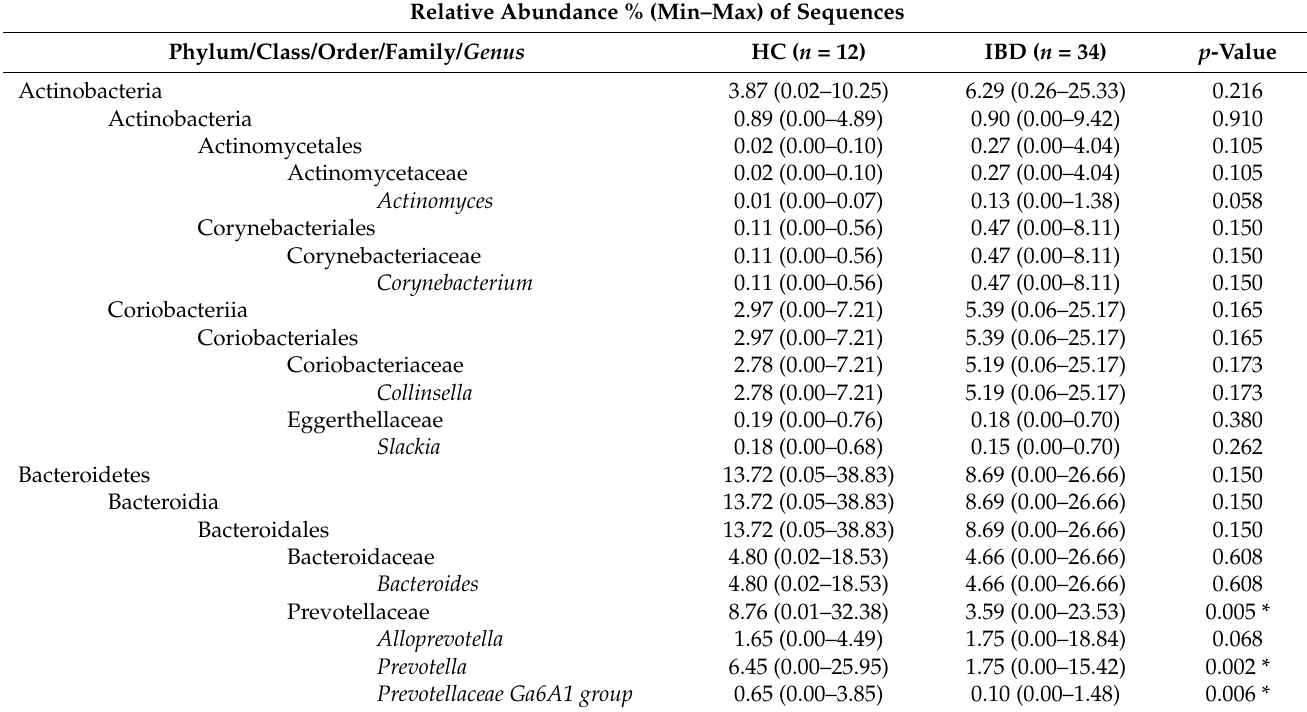
Table 5. Relative proportions of predominant bacterial taxa in the fecal samples. Relative Abundance % (Min–Max) of